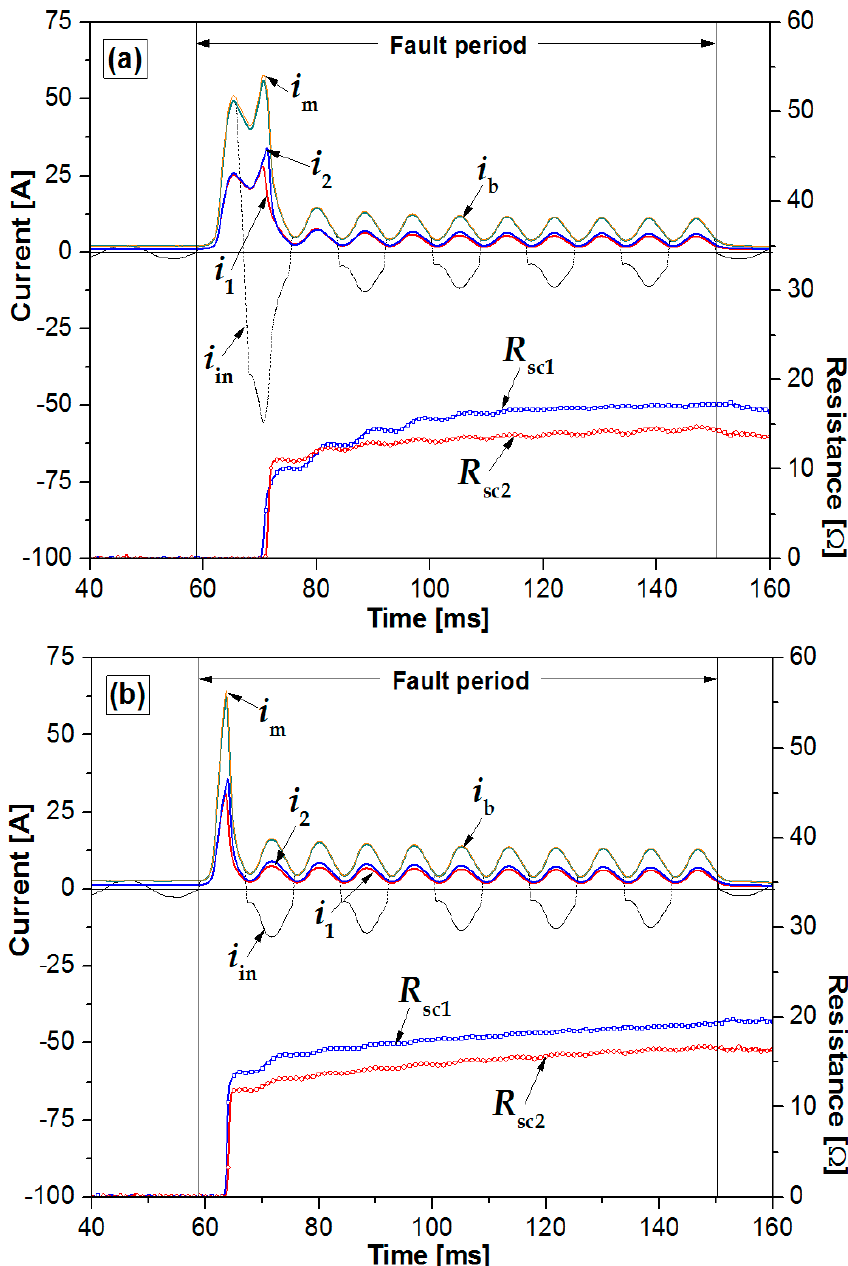
Figure 4. Fault current limiting operating characteristics of bridge type SFCL using flux-coupling according to the change of input voltage source. ( a ) E in = 80 V rms . ( b ) E in = 100 V rms .